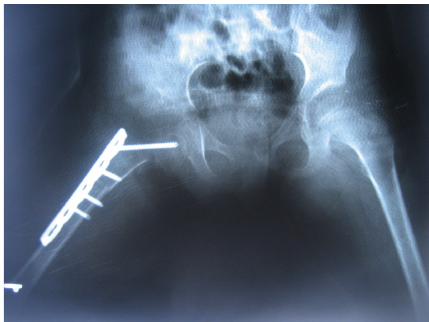
Figure 4: Revision surgery with open reduction and internal fixa- tion of the femoral neck fracture combined with femoral shortening and derotation